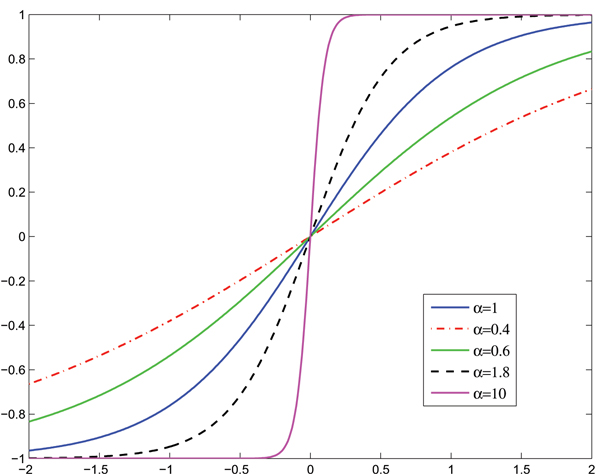
Hyperbolic tangent function. Plot of the hyperbolic tangent function y = tanh(αx) for different values of α. The function approaches a step function at increasingly high values of α.